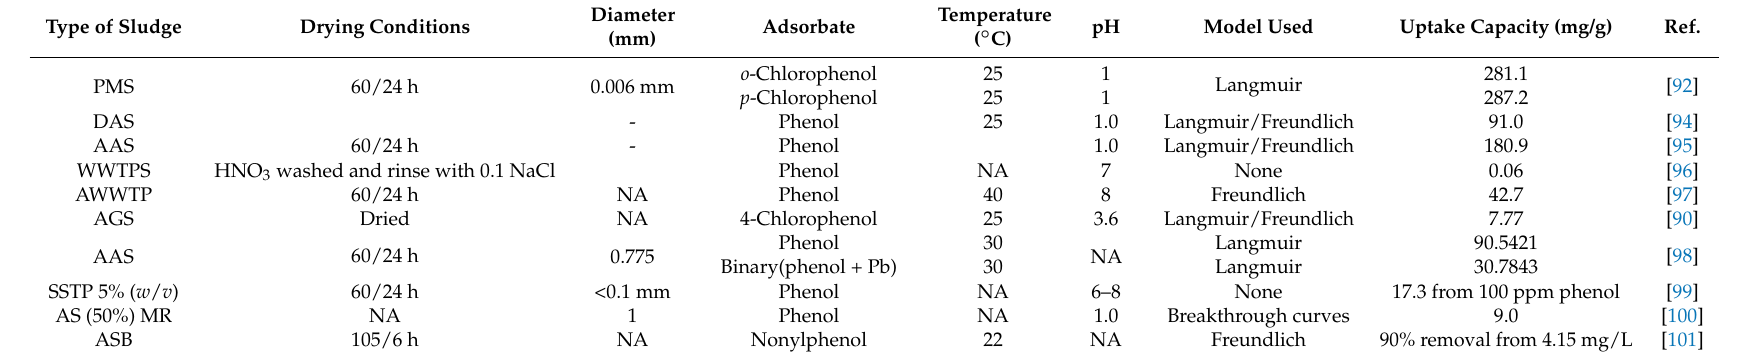
Table 5. Comparison of properties and adsorption of dried activated sludge used for phenolic compounds